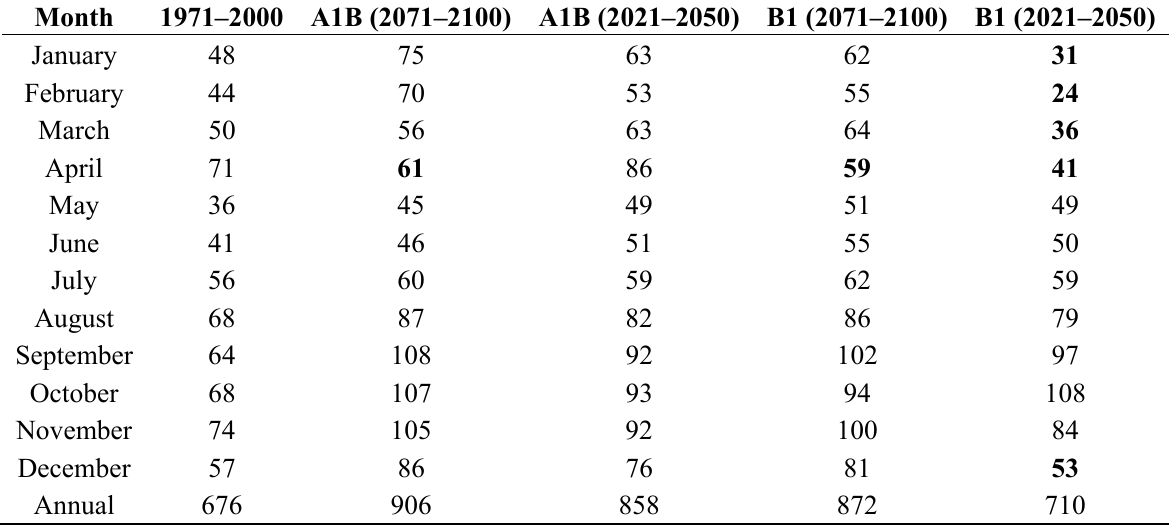
Table 2. Mean monthly potential infiltration rate (mm) over the 30 year present period (1971–2000) and in the A1B and B1 scenarios during the periods 2021–2050 and